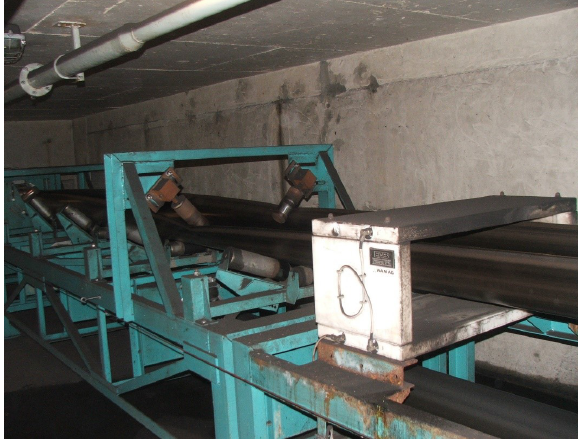
Figure 3: Electromagnetic device for removing metallic particles [8]